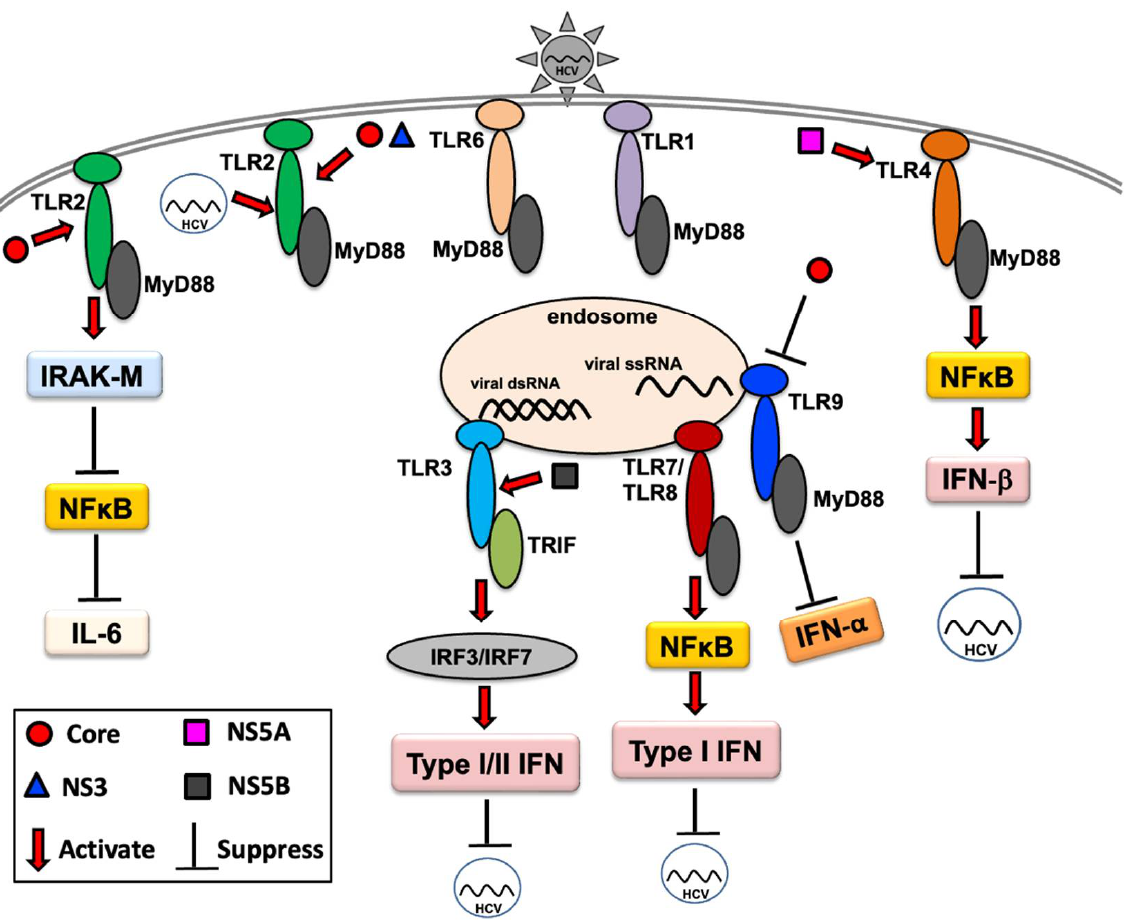
Figure 1. TLR response to HCV infection. Red arrows indicate the induction/activation of compo- nents of TLR signaling by HCV or its proteins; black lines indicate the inhibition of the host innate immune response or inhibition of HCV replication, as appropriate.